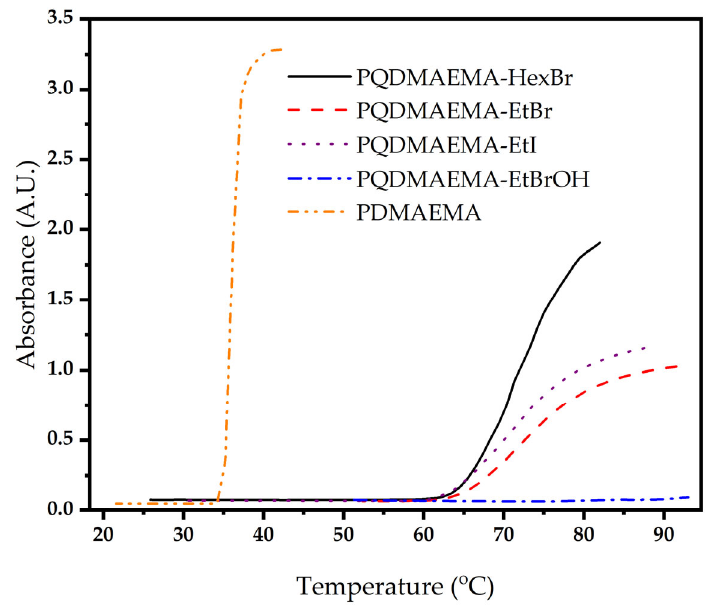
Figure 1. Absorbance vs. temperature curves for 1 wt% aqueous solutions of the PDMAEMA, PQDMAEMA-EtI, PQDMAEMA-EtBr, PQDMAEMA-HexBr and PQDMAEMA-EtBrOH copolymers at pH 9.5.